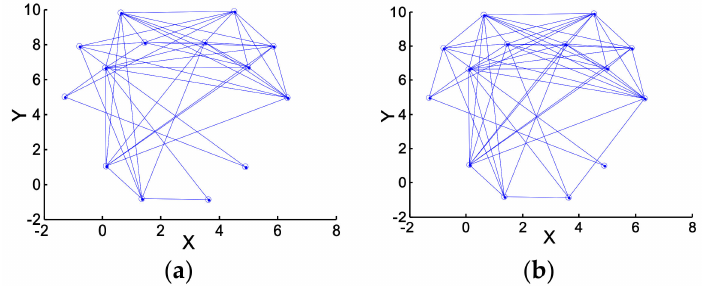
Figure 8. The difference of brain networks when moving right and left. ( a ) Move to the left; ( b ) move to the right.